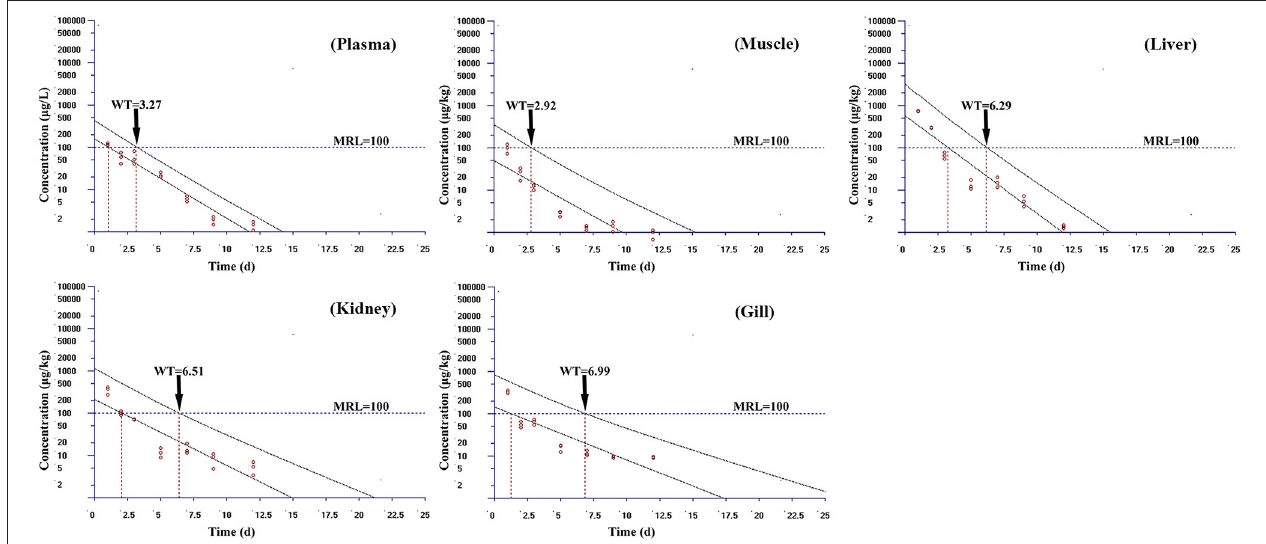
FIGURE 4 | The withdrawal time (WT) of tiamulin in plasma, muscle plus skin, liver, kidney, and gill at 30 ◦ C calculated by WT 1.4